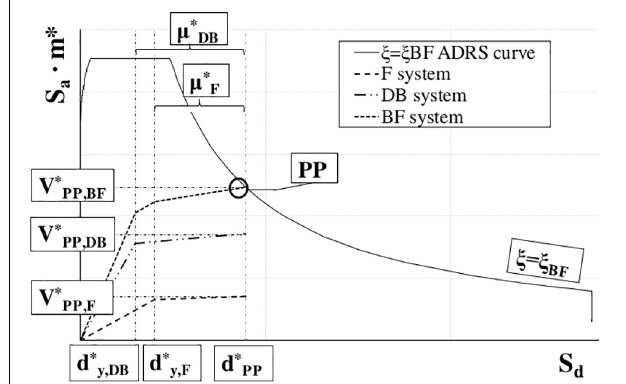
FIGURE 3 | F, DB, and BF capacity curves vs. demand